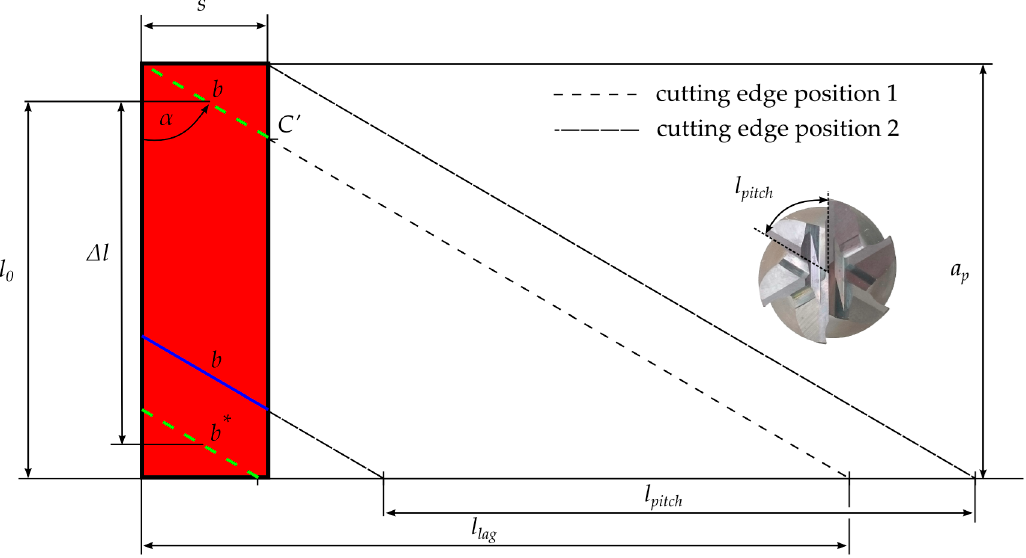
Figure 3. “Uncoiled” contact zone from Figure 2a with two possible cutting edge positions at different points in time.